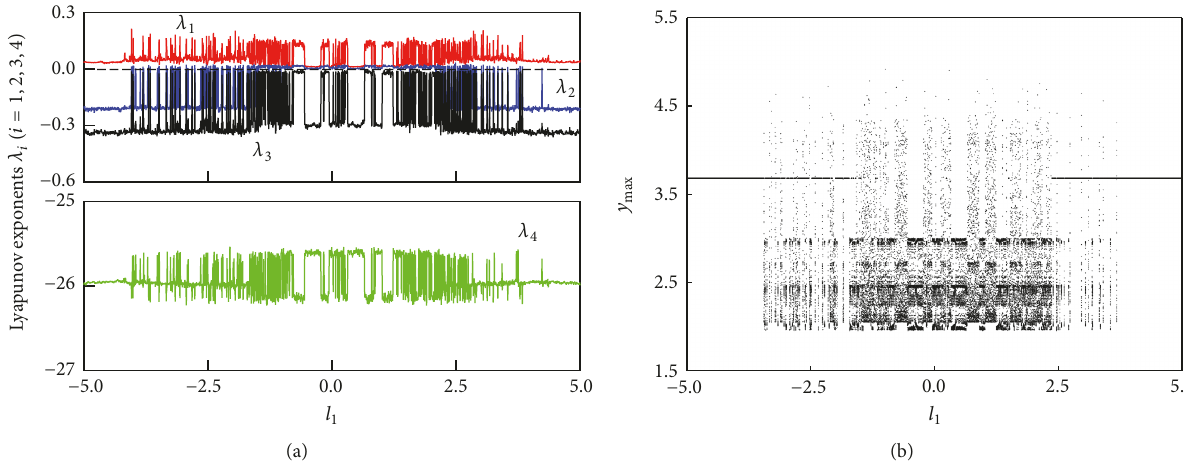
Figure 4: Lyapunov exponents and bifurcation diagram with parameter 𝑙 1 changing (a) 𝜉 = 1.68 , Lyapunov exponents, and (b) 𝜉 = 1.68 , bifurcation